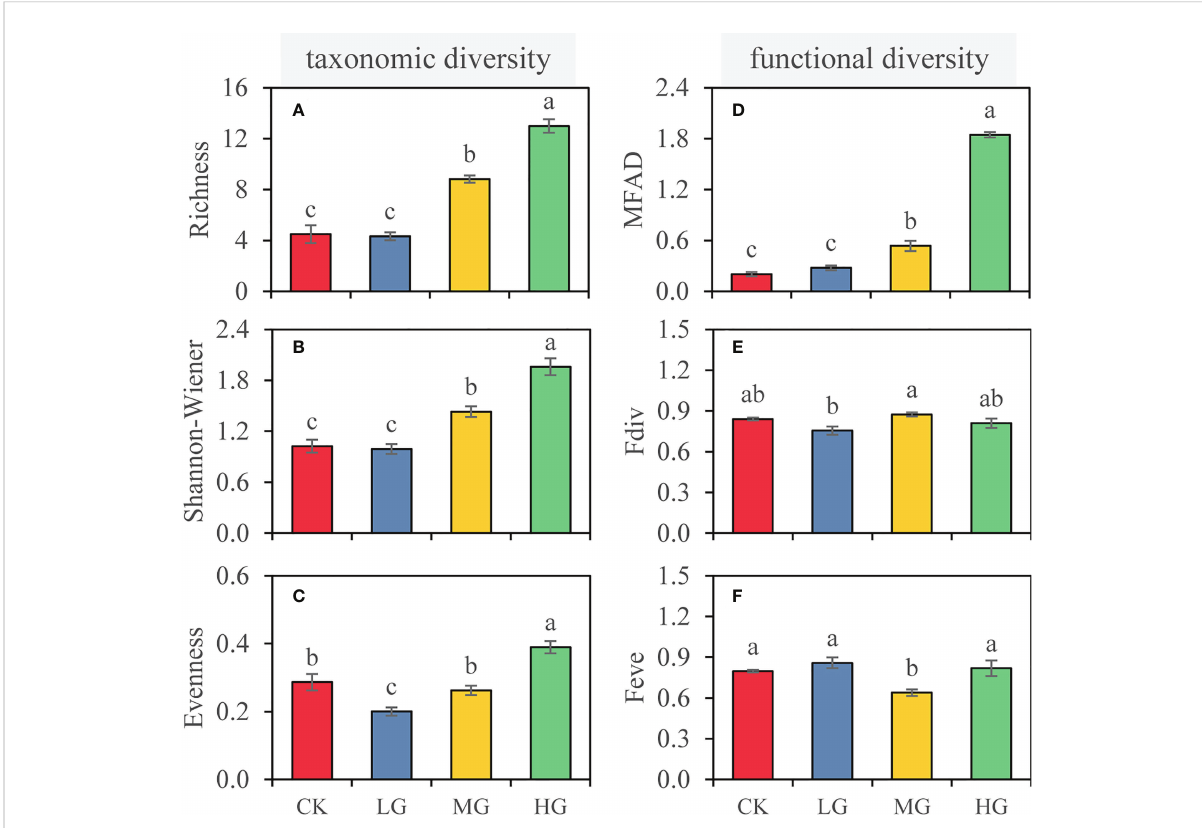
FIGURE 2 Taxonomic diversity (left) and functional diversity (right) of each grazing intensity. (A) Species richness, (B) Shannon-Wiener index, (C) species evenness, (D) modi fi ed functional attribute diversity (MFAD), (E) functional divergence (Fdiv), and (F) functional evenness (Feve). Values represent the mean ± SE. Different letters represent signi fi cant differences among grazing intensities at the p = 0.05 level. (CK, no grazing; LG, light grazing; MG, moderate grazing; HG, heavy